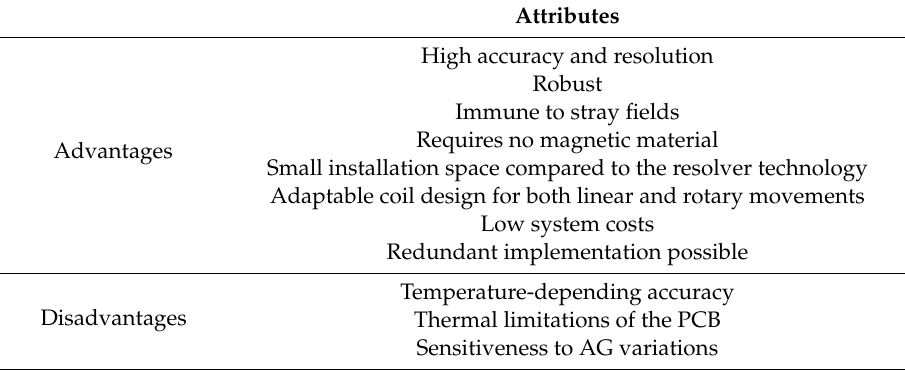
Table 2. Summary of pros and cons of the inductive position sensor principle.